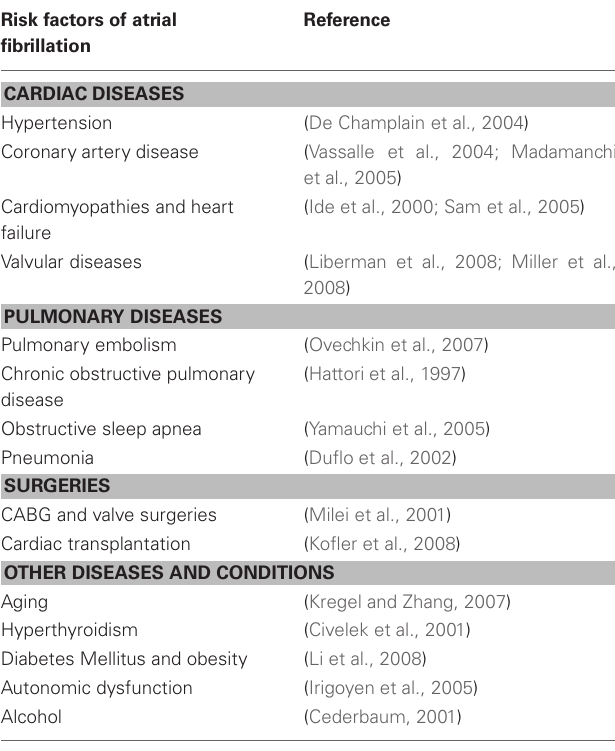
Table 5 | Gene expression and protein level of pro-oxidants and antioxidants in the right atrial appendage of AF patients compared to patients in sinus